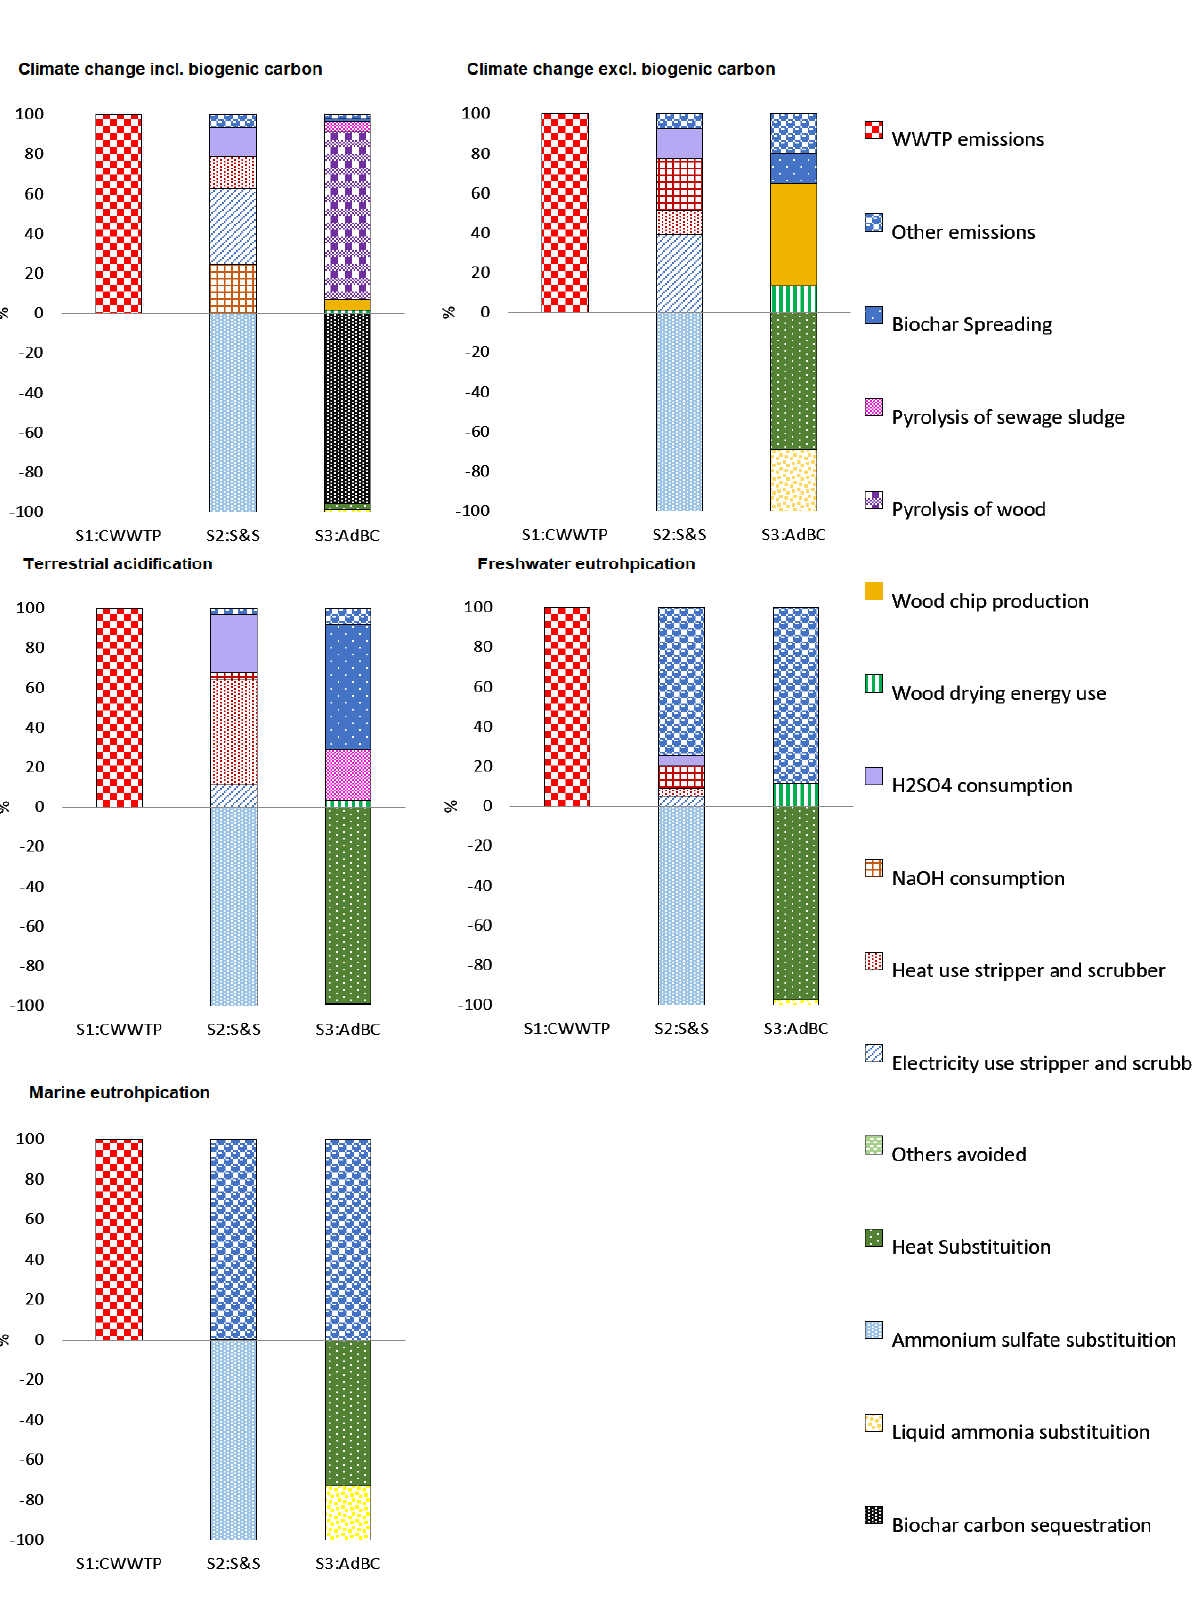
Figure 2. LCIA contribution assessment of scenarios S1 (CWWTP), S2 (S&S), and S3 (AdBC) for the selected impact categories.